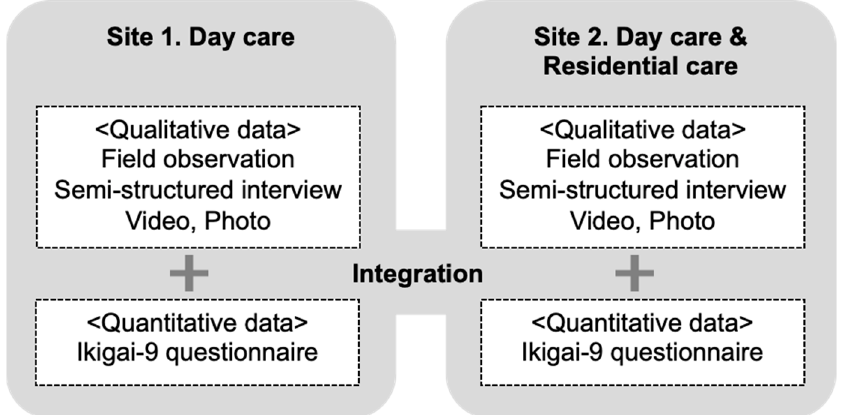
Figure 1. A qualitatively driven mixed-methods multiple-case study design. The qualitative data analysis was conducted, and the quantitative data were then examined. The data set of each site were compared to explore the elements of the implementation contributing to the well-being of the older participants.